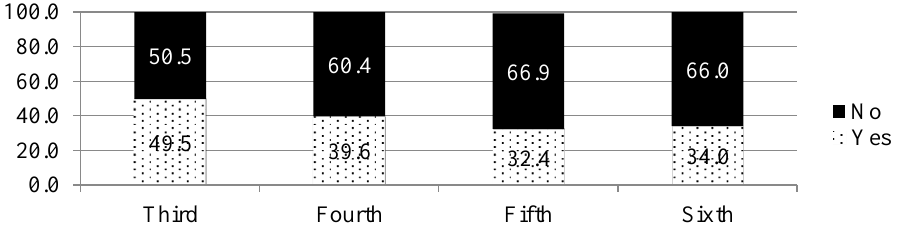
Figure 2. Pupils’ preference to watch/listen to commercials (per grade - legend: third grade - nine years, fourth grade - ten years, fifth grade - eleven years and sixth grade